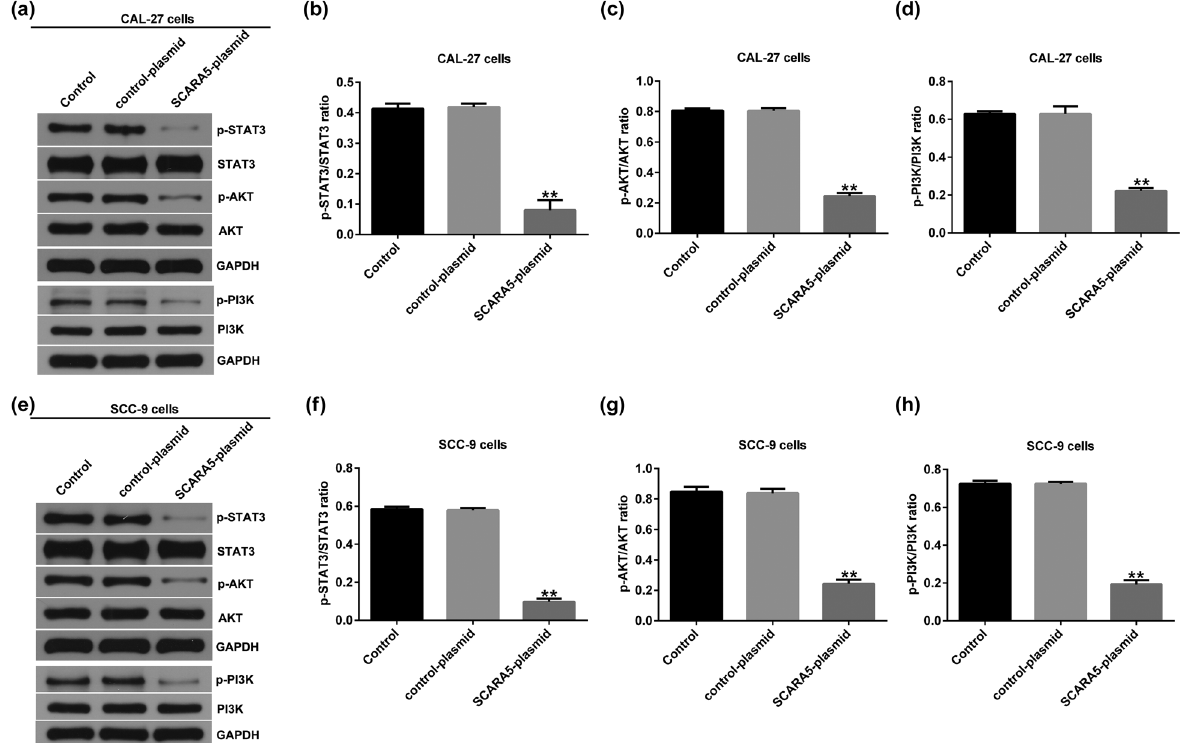
Figure 5: E ff ects of SCARA5 on STAT3 and PI3K/AKT signaling pathways in OSCC cells. ( a ) Western blot analysis of the expression of p - STAT3, STAT3, p - AKT, AKT, p - PI3K, and PI3K in CAL - 27. ( b – d ) The ratio of p - STAT3/STAT3, p - AKT/AKT and p - PI3K/PI3K. ( e ) . Western blot analysis of the expression of p - STAT3, STAT3, p - AKT, AKT, p - PI3K and PI3K in SCC - 9 cells. ( f – h ) The ratio of p - STAT3/STAT3, p - AKT/AKT and p - PI3K/ PI3K. ** p < 0.01 vs control